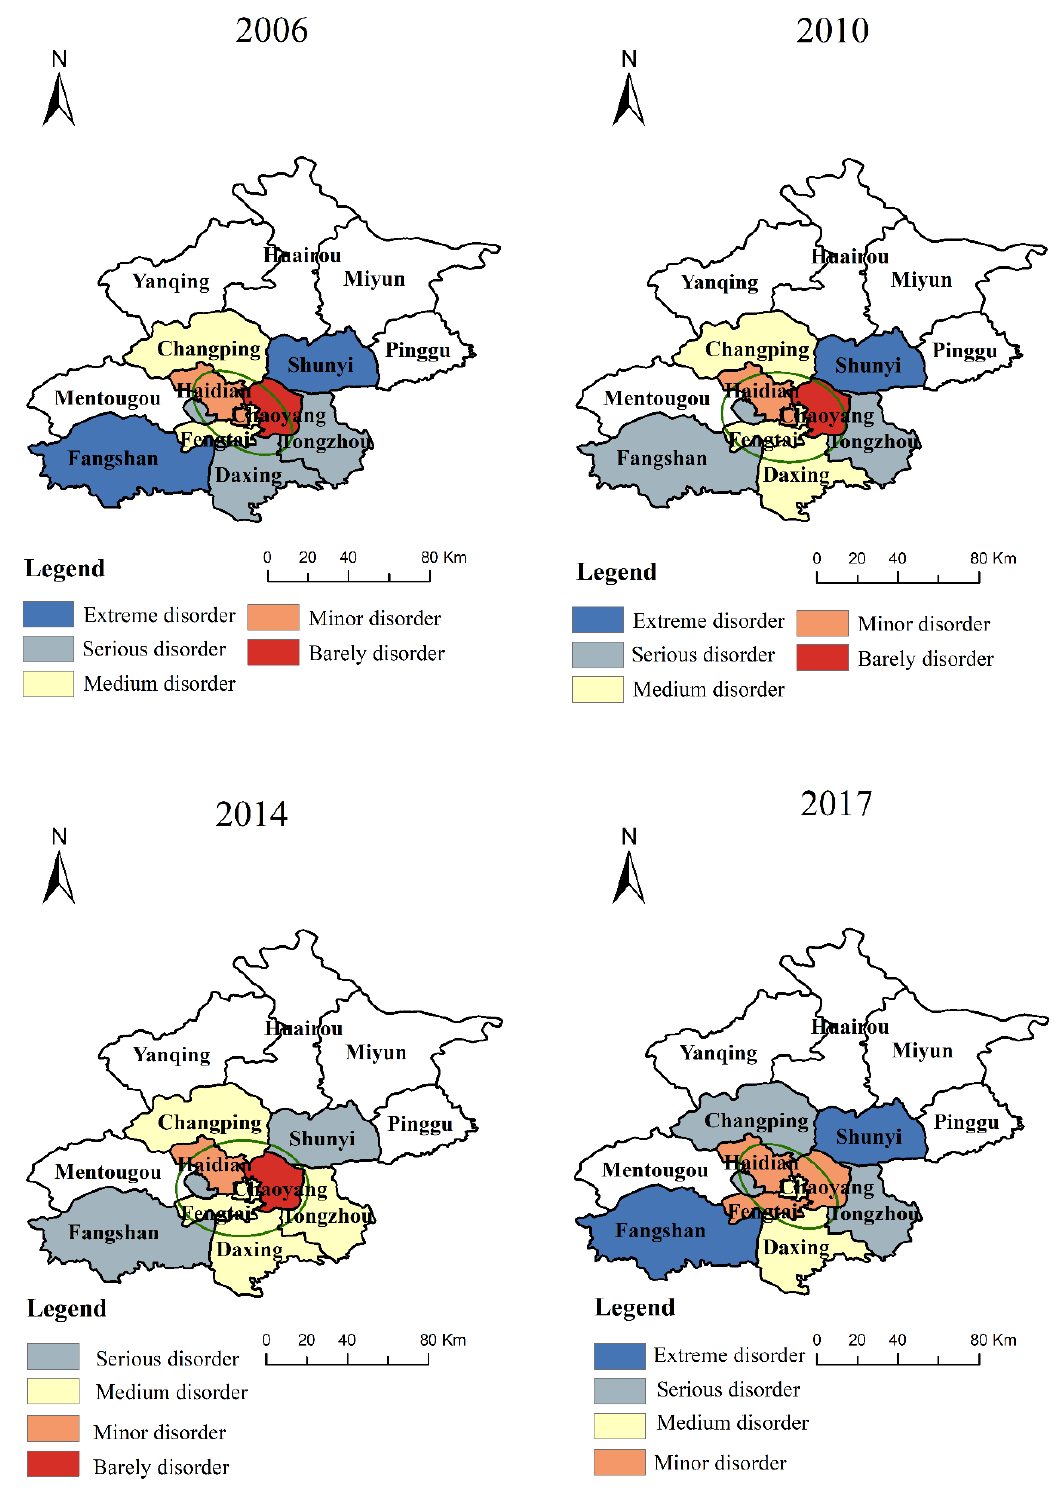
Figure 3. The spatiotemporal distribution of the overall coupling coordination degree. According to the spatial evolution pattern of the standard deviational ellipse of the coupling coordination degree between RU and RT in Figure 3, the standard deviational ellipse of the overall coupling coordination degree of each system from 2006 to 2017 is consistent, which is mainly distributed in the central urban area, Changping, and Shunyi.